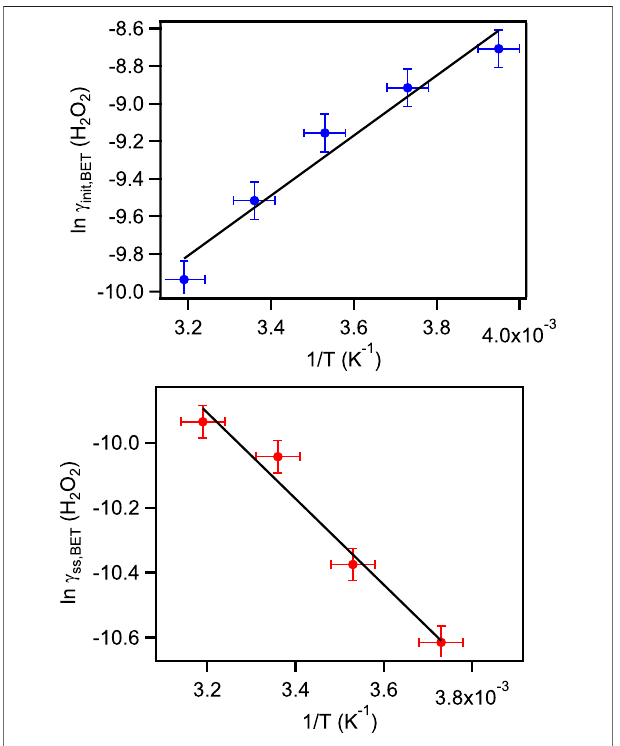
FIGURE 6 | Relationship between the initial uptake coef fi cients (upper panel) and steady state uptake coef fi cients (lower panel) of sulfur dioxide on coal fl y and temperature.